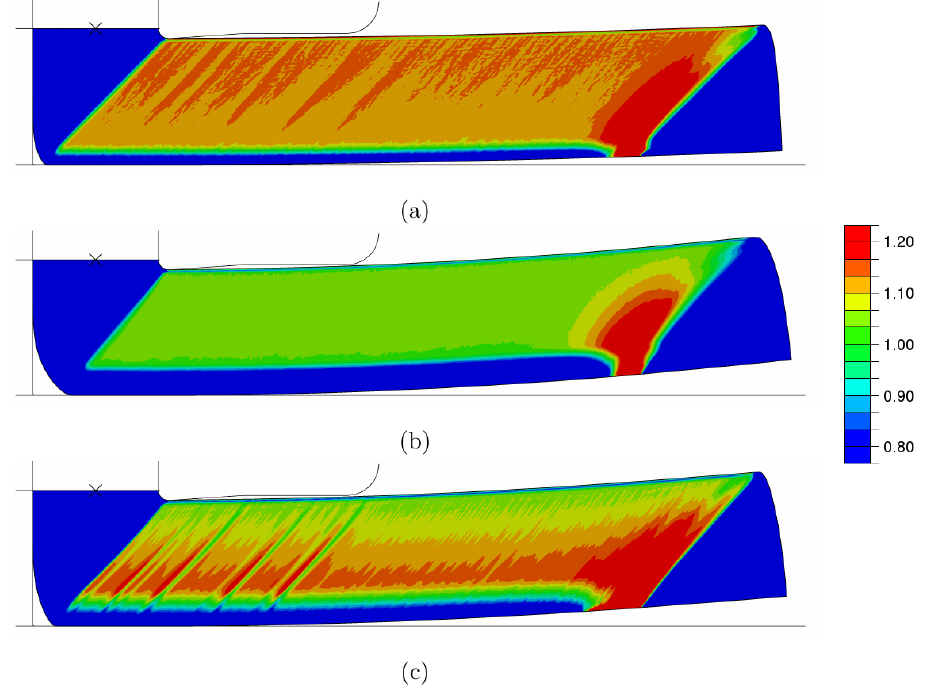
Figure 6. Effective plastic strain s (cf. Equaiton (9)) for simulations with isotropic hardening with γ = 200 MPa in combination with ( a ) β = 0.1, ( b ) β = 1.0 and ( c ) β = 10.0. σ β In ( a , c ), minor fluctuations occur; ( b ) shows a quasi-homogeneous distribution of the effective plastic